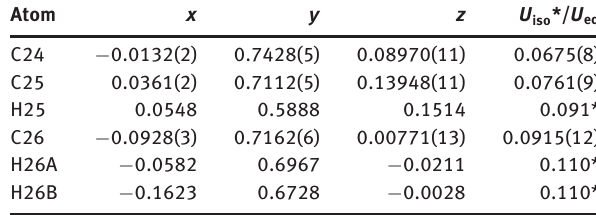
Table 2: Fractional atomic coordinates and isotropic or equivalent isotropic displacement parameters (Å 2